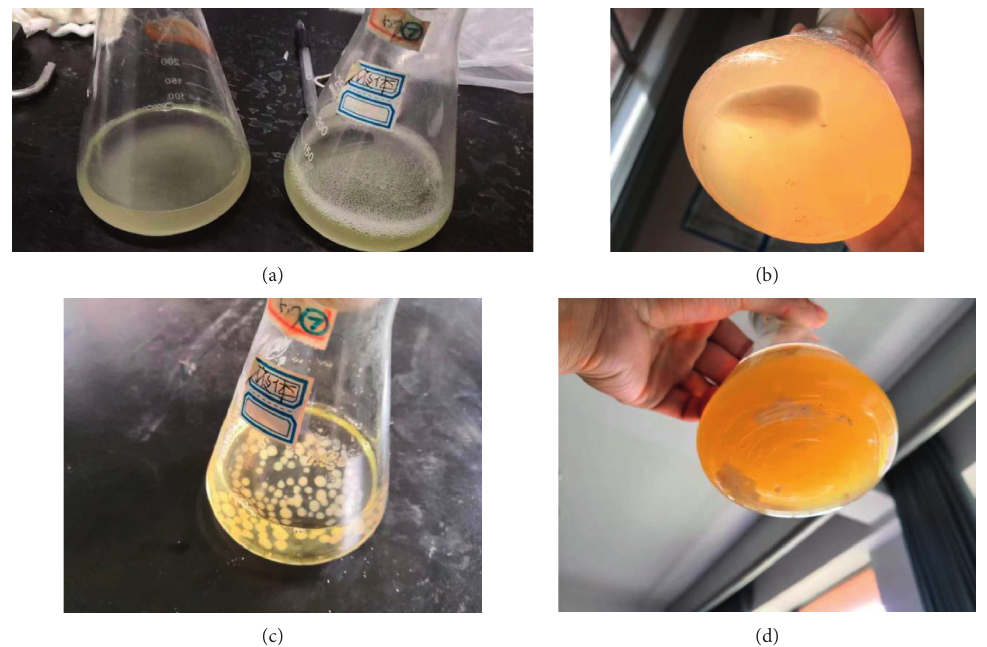
Figure 5: Mineralization process with Bacillus mucilaginosus added.